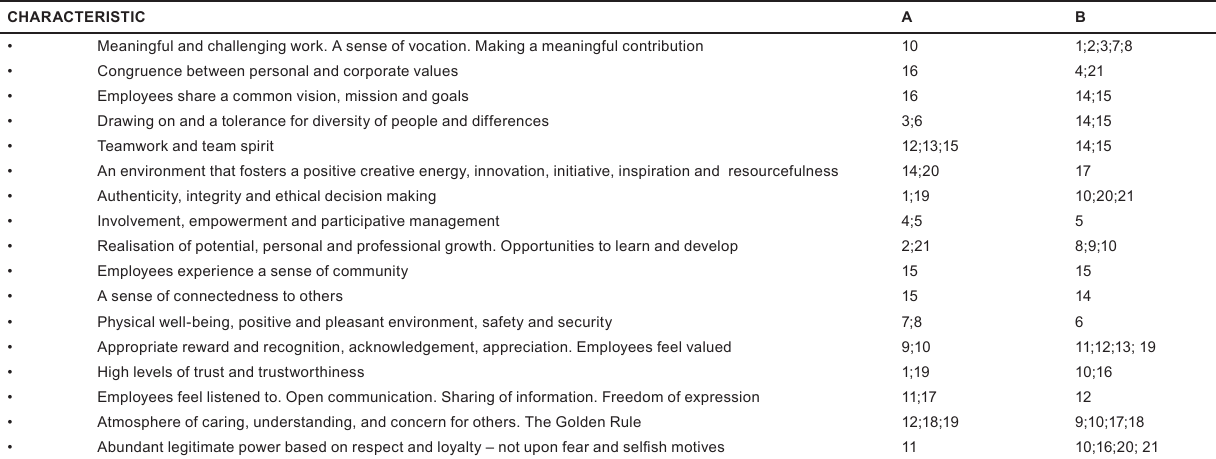
TABLE 7 Linking characteristics of spirituality to